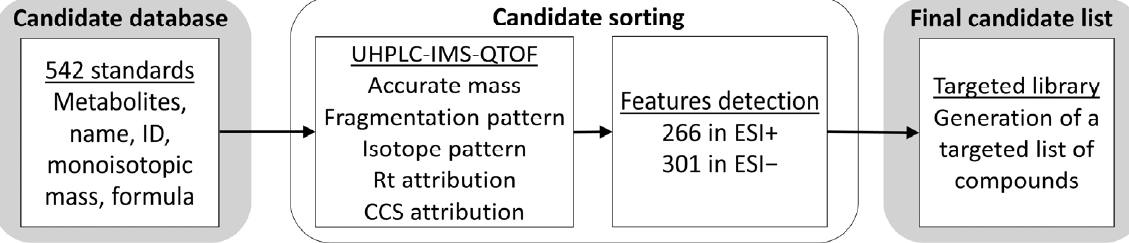
Figure 1. Workflow and results of the targeted-based metabolomic approach developed. Metabolites belong to different chemical classes and are mainly carbohydrates, car- boxylic acids, lipids, nucleotides, and organoheterocyclic compounds (Figure 2) involved in different pathways that reflect the metabolic status in biological matrices of interest.